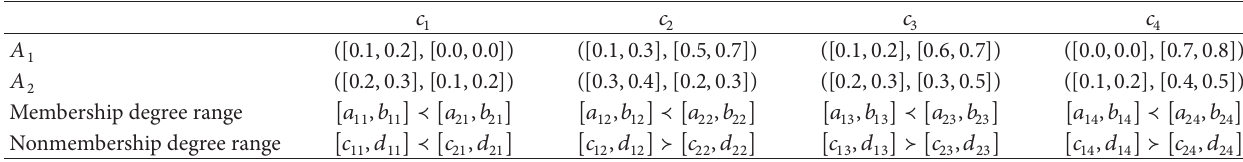
Table 2: The detailed comparison of 𝐴 1 and 𝐴 2